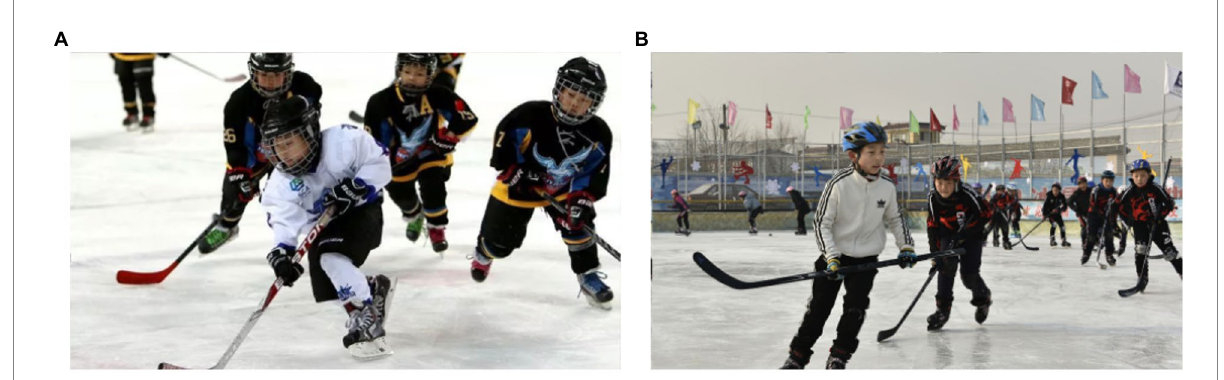
FIGURE 11 The teaching situation of the Olympic sports in the school [ (A) and (B) represent the real pictures of different links of the Olympic sports]. Reproduced with permission from Beijing Yanqing District Education Commission, available at https://m.sohu.com/a/315362623_161623.